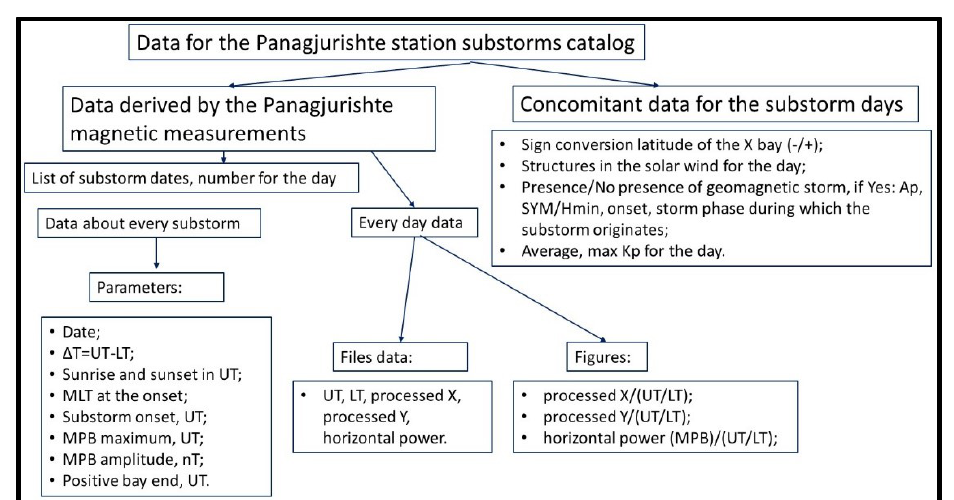
Fig. 1. Scheme of the structure of the Panagjurishte substorm